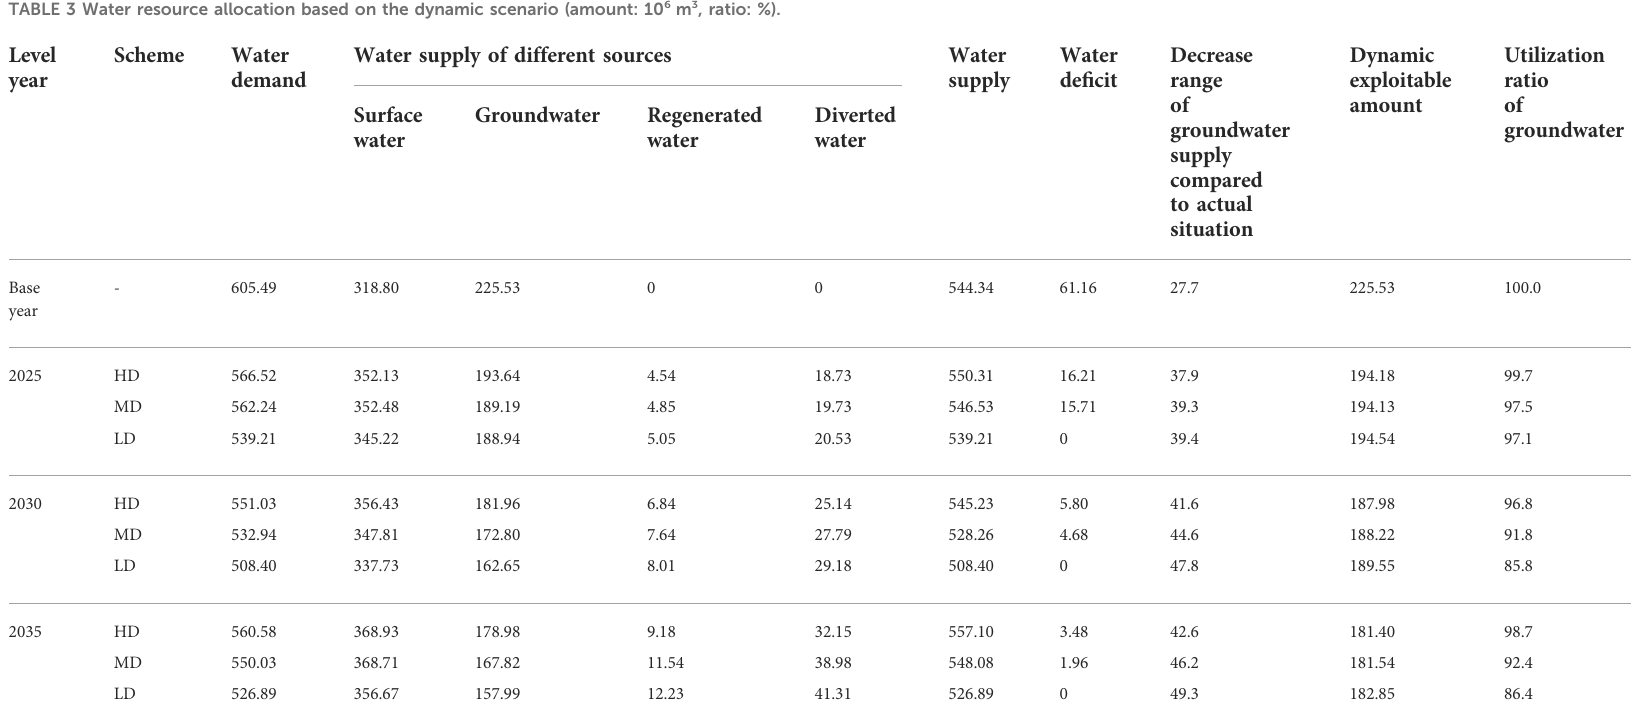
TABLE 3 Water resource allocation based on the dynamic scenario (amount: 10 6 m 3 , ratio: